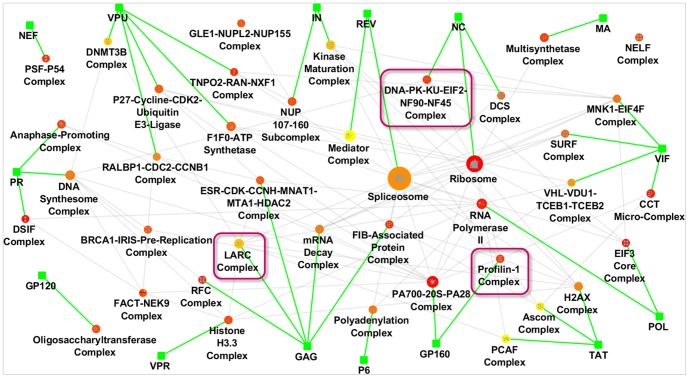
Map of HIV-human protein complexes.40 identified human protein complexes are shown together with the HIV protein targeting the complex. Green rectangles correspond to HIV proteins. Human complexes are shown as ellipses. A color gradient from red (high) to yellow (low) indicates the average rank of the complex in the APMS- and RNAi-propagations. Node size corresponds to number of subunits in the complex. Gray edges represent functional interactions between the human complexes; green edges are HIV-human interactions. Purple boxes indicate protein complexes that were selected for follow-up RNAi screens.